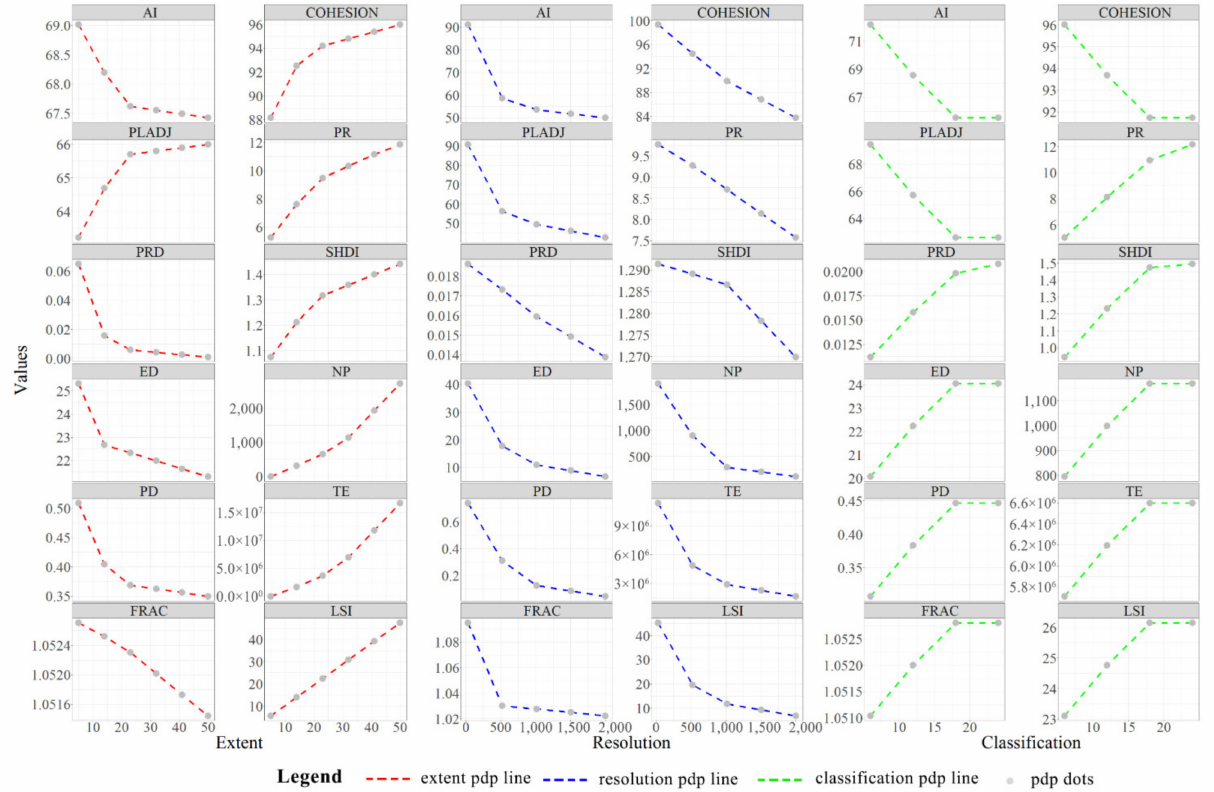
Figure 4. The single-scale response lines of 12 landscape metrics. php means the PHP